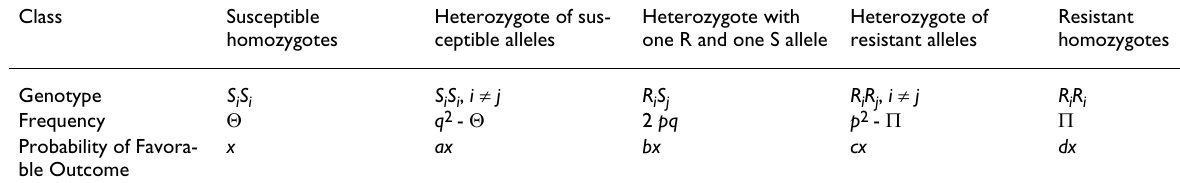
Table 1: Frequency and disease risk of 5 classes of genotypes under the model.